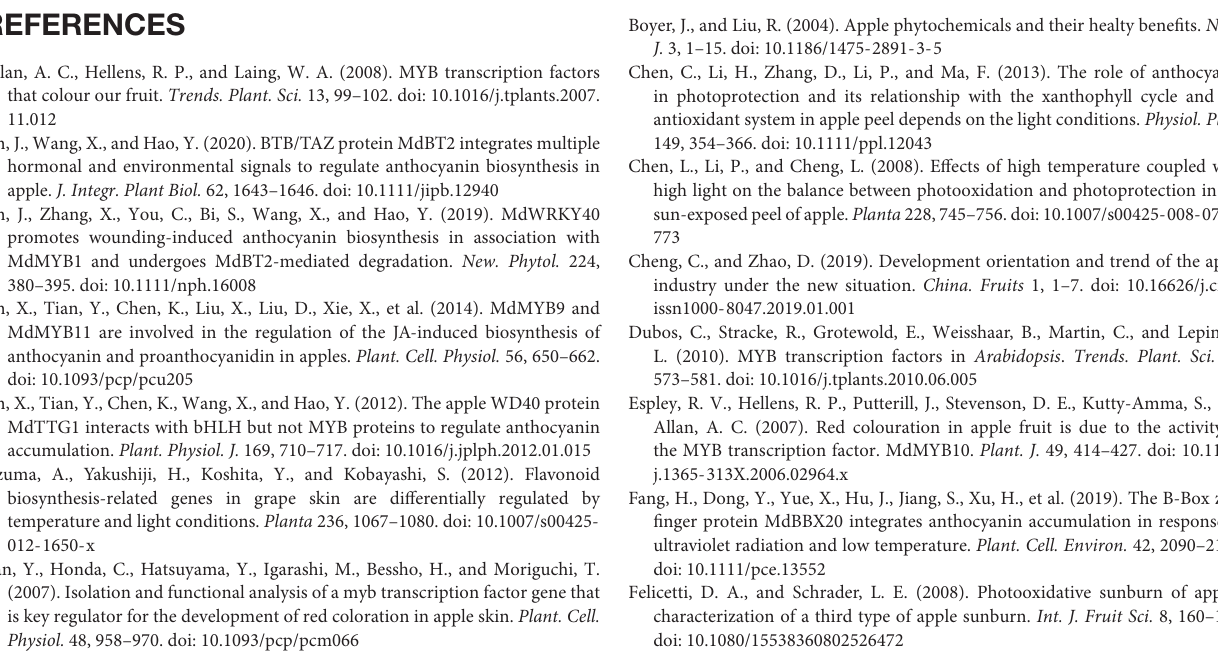
Supplementary Table 1 | Primer sequences used in the